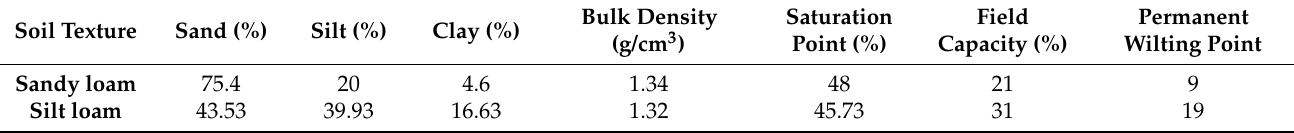
Table 1. Results of the soil physical properties.